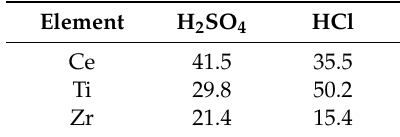
Table 4. Activation energy (kJ / mol) for the dissolution of Ce, Ti and Zr based on extraction rates from 1–5